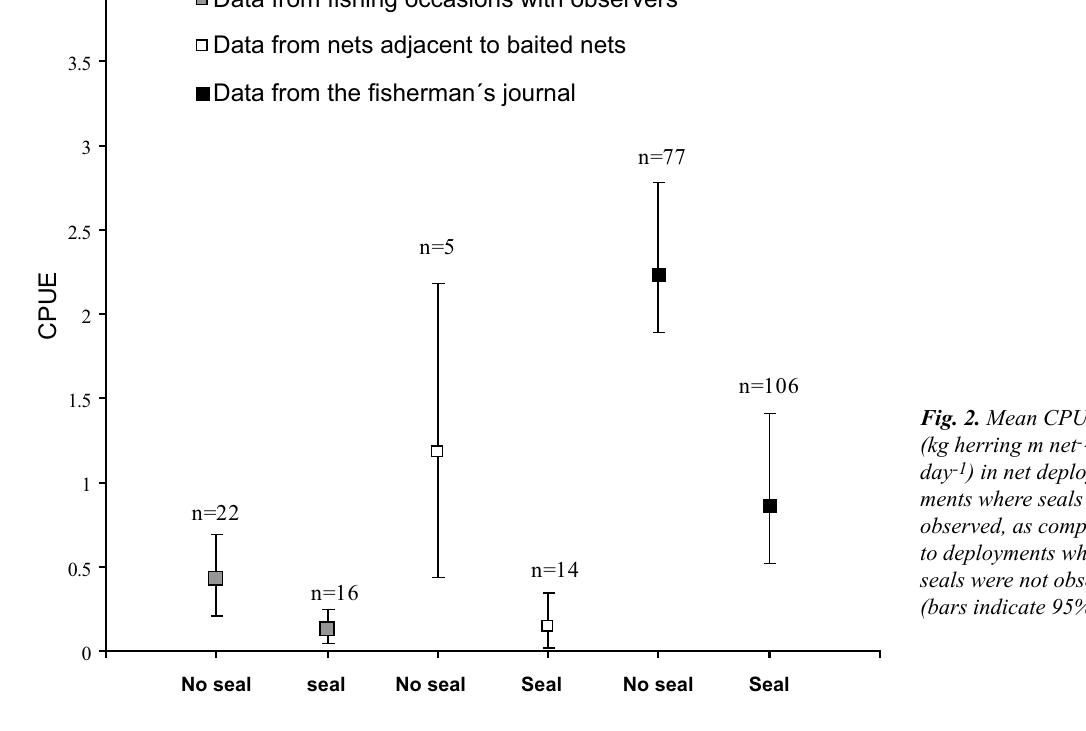
Fig. 2. Mean CPUE (kg herring m net -1 day -1 ) in net deploy - ments where seals were observed, as compared to deployments where seals were not observed (bars indicate 95%